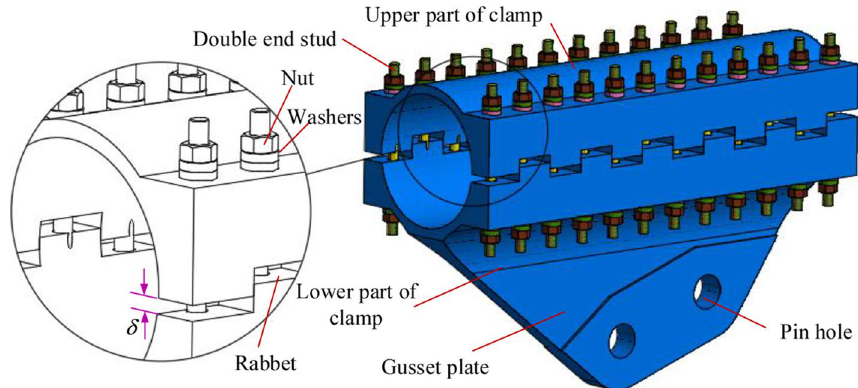
Fig. 14 Multi-row screw arrangement for cable